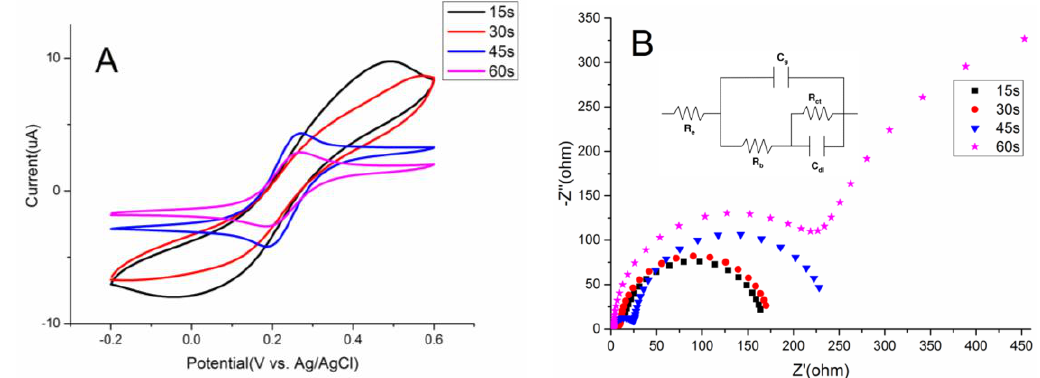
Figure 6. The cyclic voltammograms ( A ) and EIS spectrums ( B ) of 6-cycles PEDOT films with different overoxidation time in 5 mM [Fe(CN) 6 ] 4−/3− ; scan rate: 100